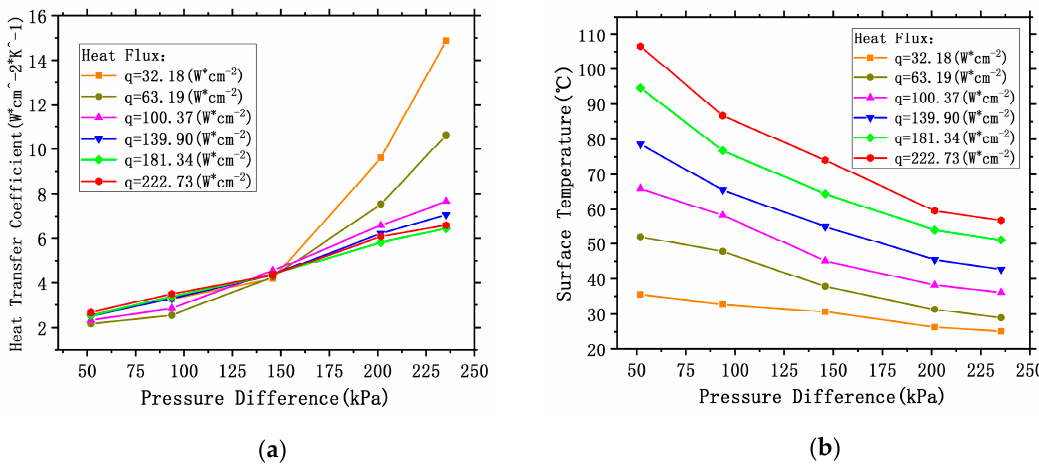
Figure 7. Characteristic heat transfer curves for various heat fluxes, ( a ) heat transfer coefficient as a function of spray cavity one (PDWIC) and ( b ) surface temperature as a function of PDWIC.